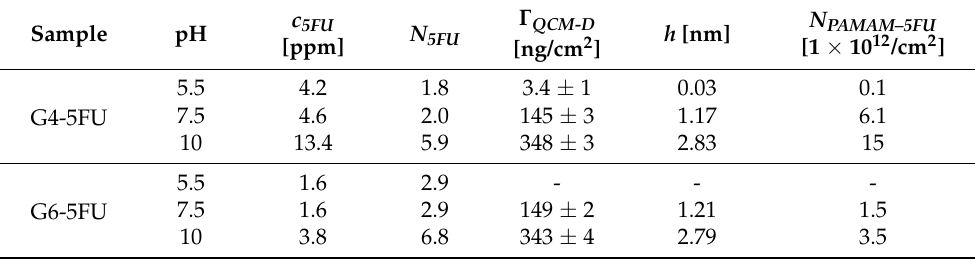
Table 4. QCM-D results of PAMAM–5FU complexes after dialysis (carrier–drug molar ratio 1:50, d = 1.23 g/cm 3